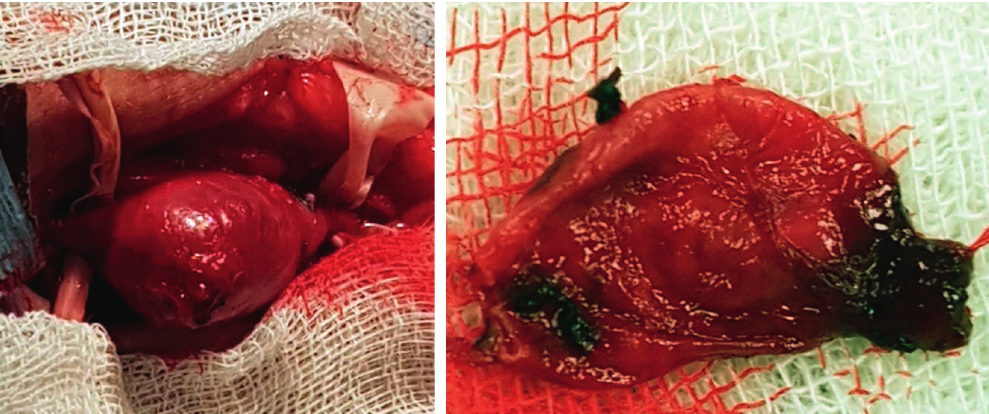
Figure 2: Brachial artery aneurysm.